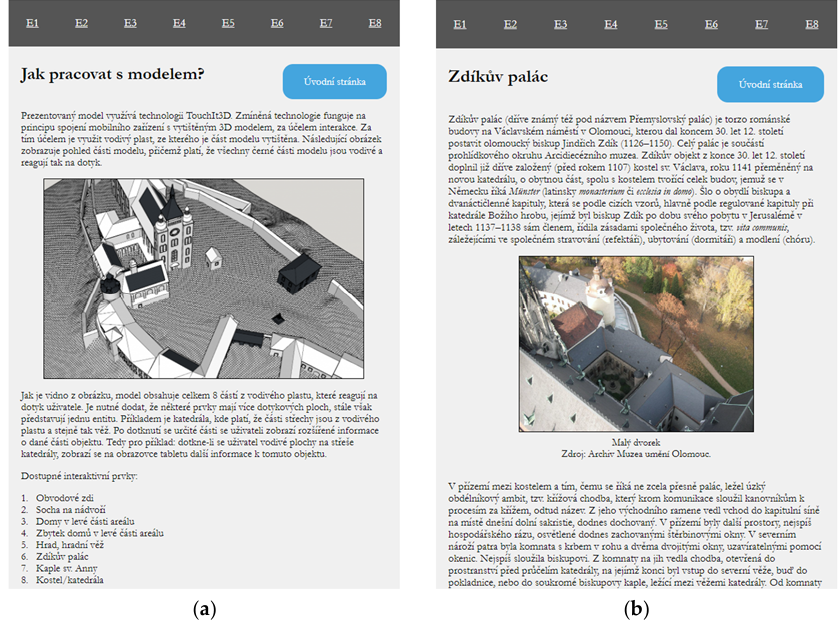
Figure 9. The web interface shows additional information about parts of the model. Since the model was originally made for the Olomouc Museum of Art in Czechia, the content is in Czech due to the majority of Czech visitors in the museum. ( a ) The page containing instructions on interacting with the model. ( b ) One of the pages with additional information about a chosen